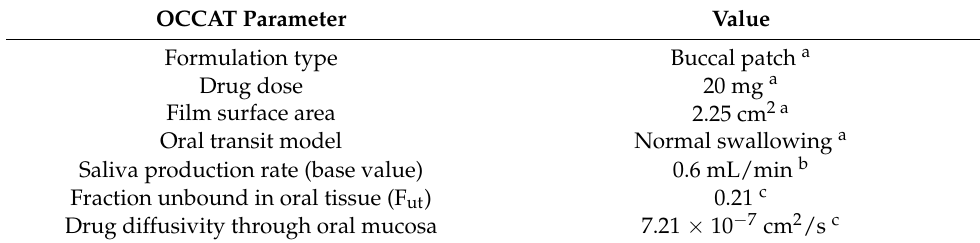
Table 2. The study-specific input parameters in the OCCAT